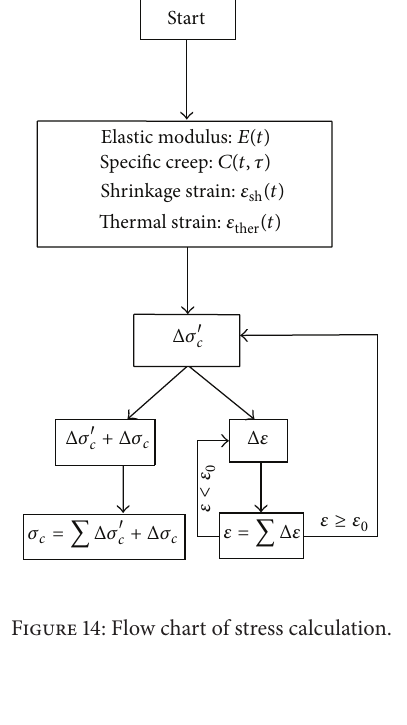
Figure 16: Comparison of experimental results and analytical